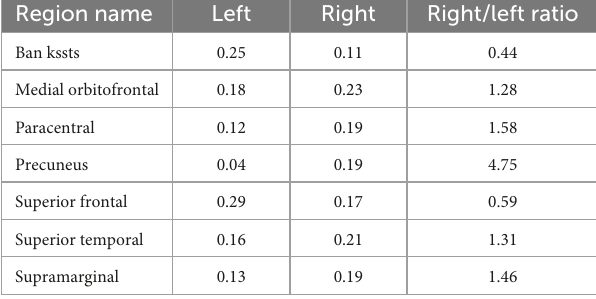
TABLE 4 R -values of the left and right hemispheres and the right/left asymmetry ratio for each region showing significant correlation between alpha peak frequency and depressive score on either